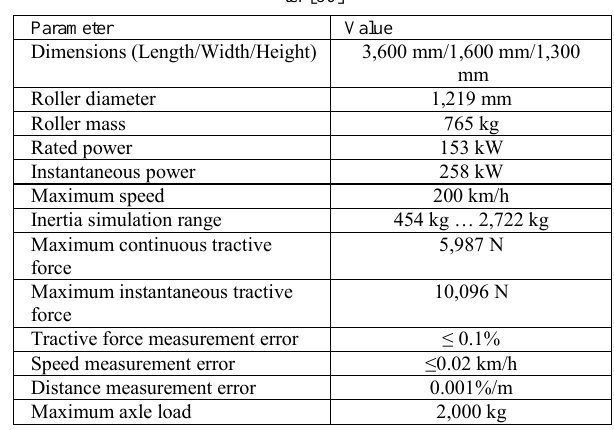
Table 1. Basic technical data of AVL ROADSIM 48ʺ Chassis Dynamome- ter [36]